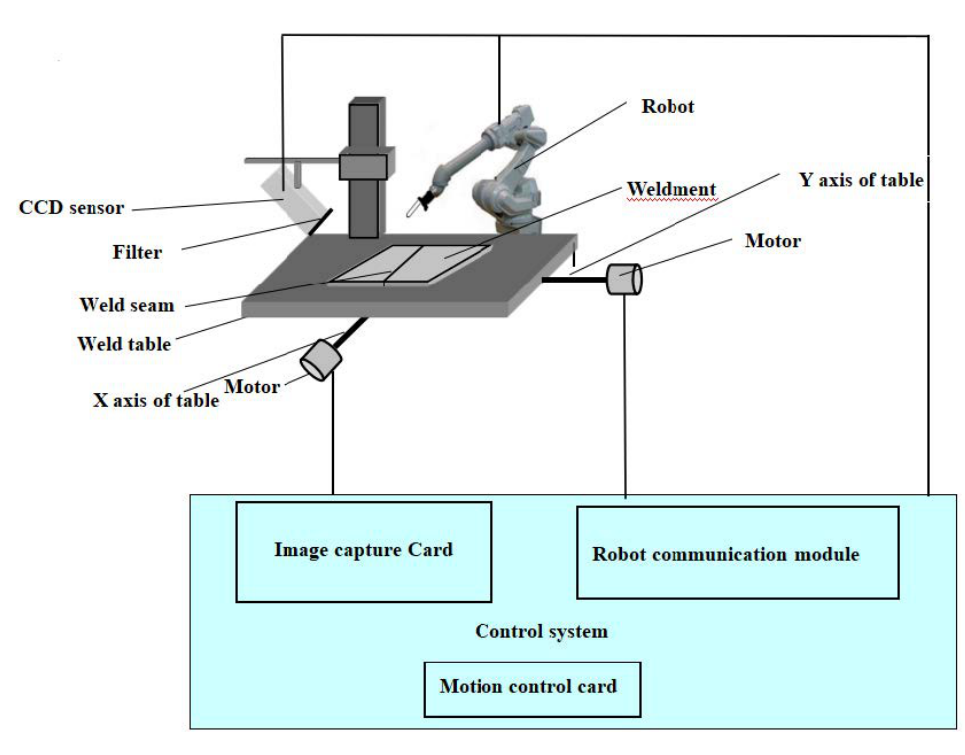
Fig. 1 Hardware structure of experimental